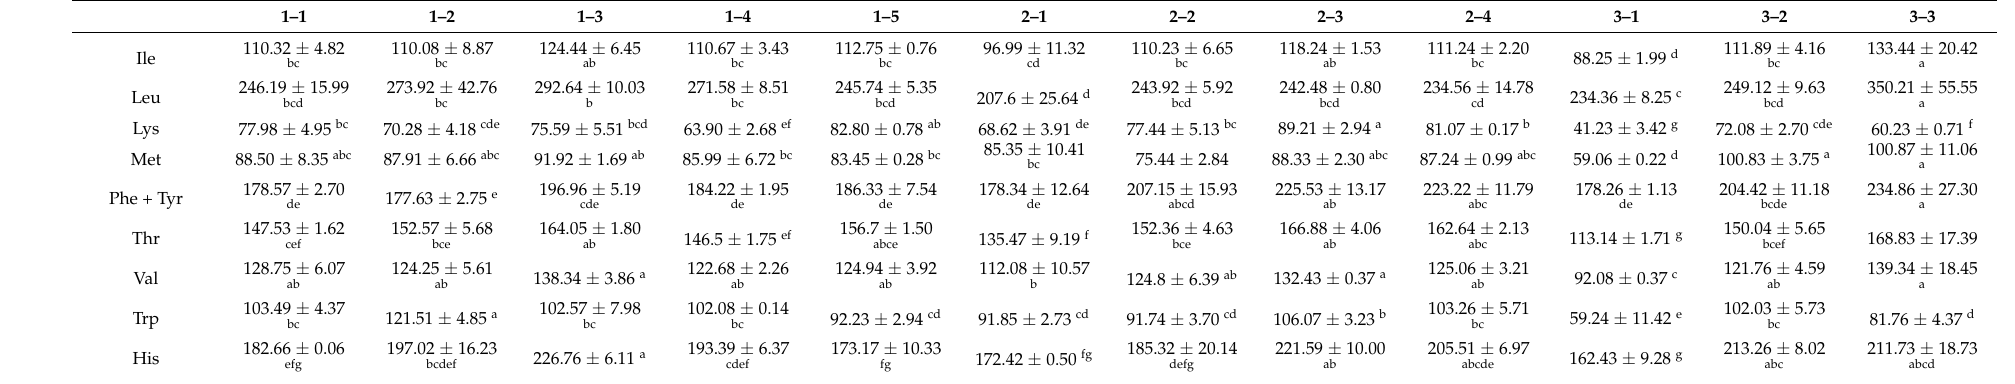
Table 6. AAS values of fresh corn from three